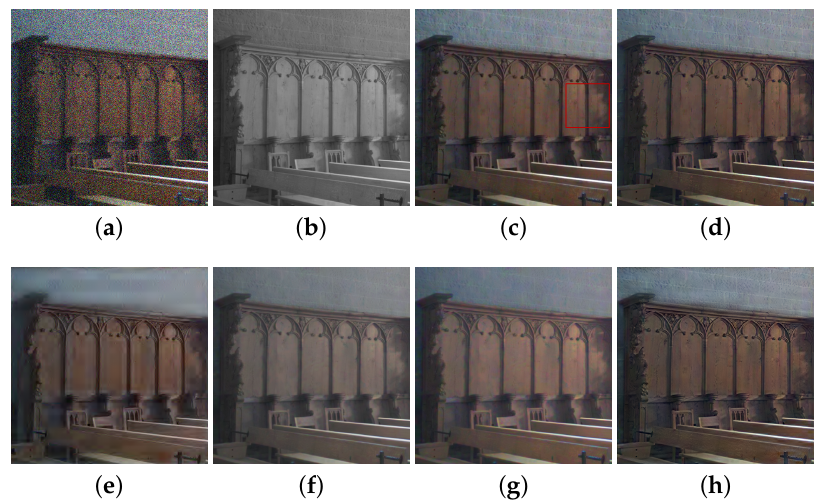
Figure 9. Experimental results for a test image. ( a ) Noisy RGB image. ( b ) NIR image. ( c ) DWLS [11].